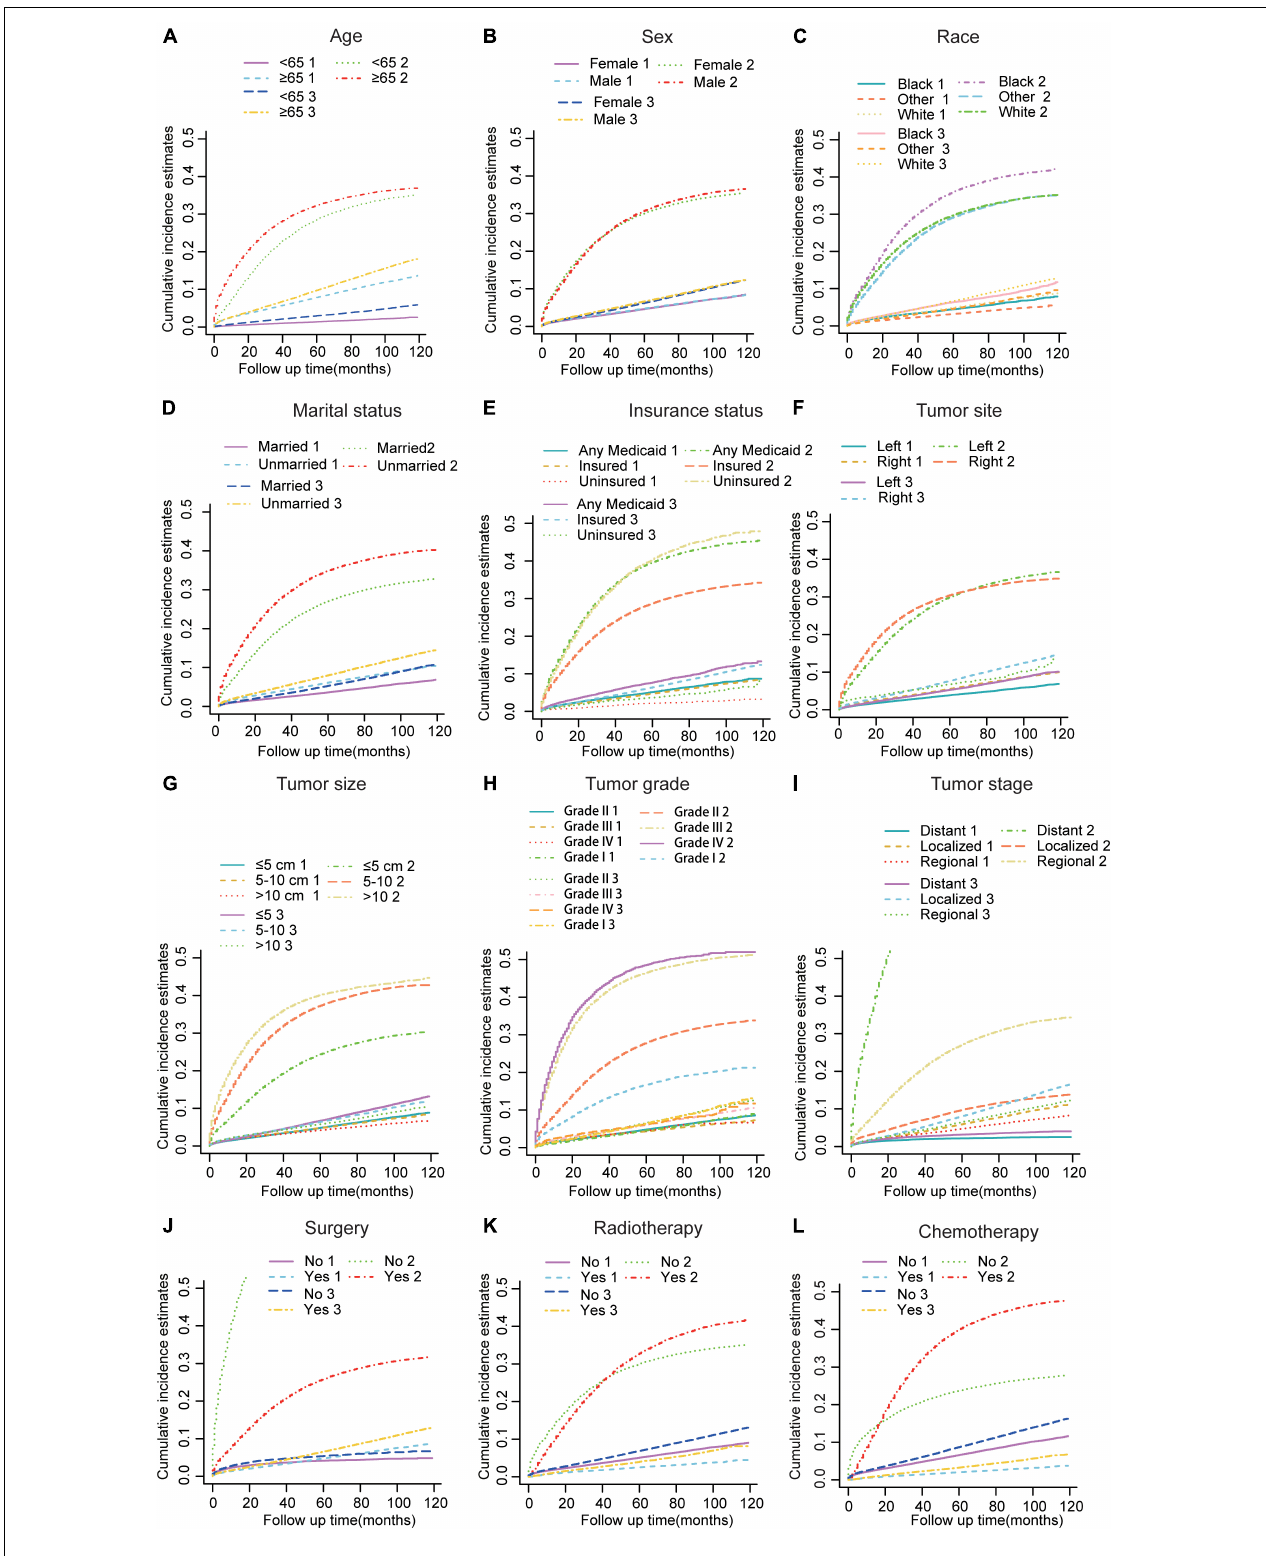
FIGURE 2 | Cumulative incidence estimates of CVD among patients with CRC according to (A) Age; (B) Sex; (C) Race; (D) Marital status; (E) Insurance status; (F) Tumor site; (G) Tumor size; (H) Grade; (I) SEER stage; (J) Surgery; (K) Radiotherapy; (L) and Chemotherapy. A solid line represents cause-specific death, while a dotted line represents other causes of death. Death from CVD was indicated as 1; death from CRC was indicated as 2; and death from non-CVD was indicated as 3.